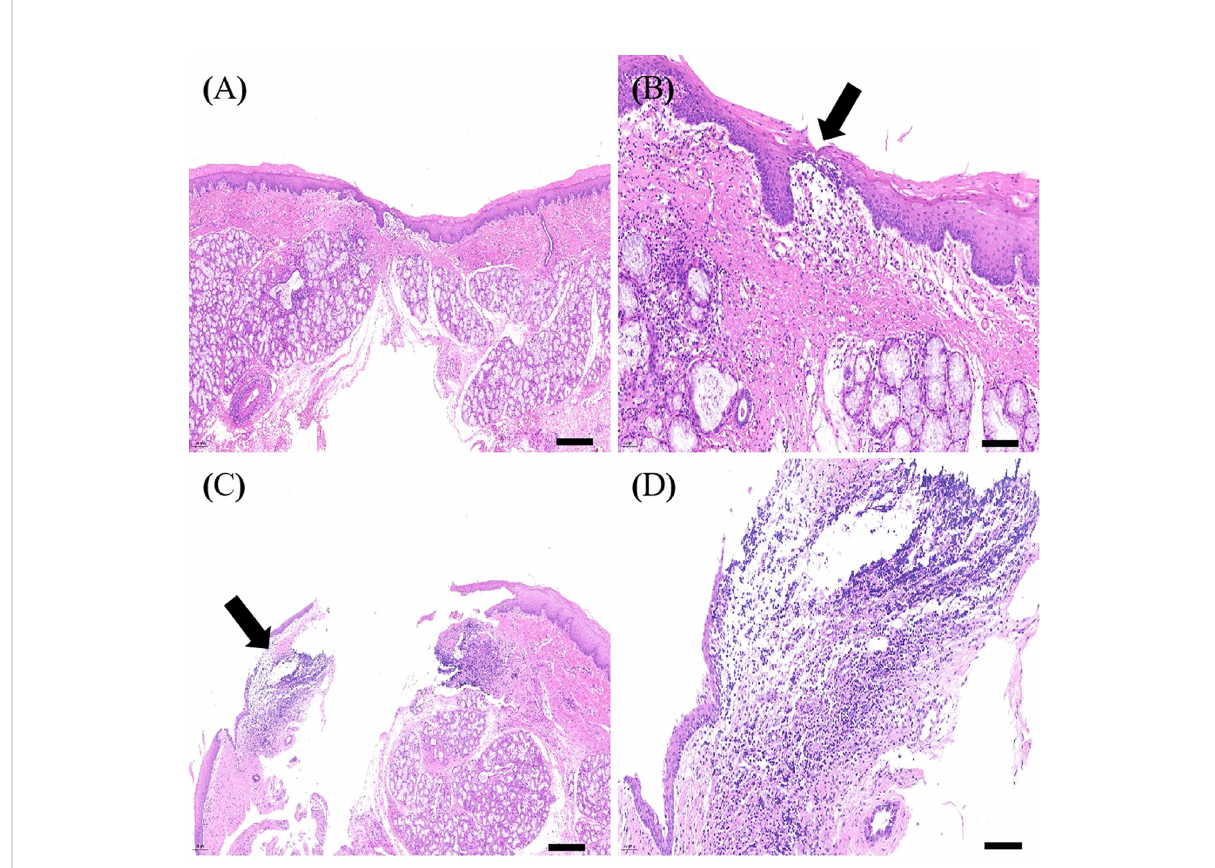
FIGURE 8 The representative images of HE staining of the esophagi at EALs. (A) , The complete occlusion of EAL (Scale bar:200 m m). (B) , In fl ammatory cells in fi ltrating around EAL from adventitia to muscular layer (Scale bar:50 m m). (A, B) , Representative images of HE staining of the esophagi at EALs in MSCs group. (C) , The incomplete occlusion of EAL (Scale bar:200 m m). (D) , Dispersive in fi ltration of in fl ammatory cells in the full-thickness esophageal tissue (Scale bar:50 m m). (C, D) , Representative images of HE staining of the esophagi at EALs in the control group. EAL, esophageal anastomotic leakage; MSCs, mesenchymal stromal